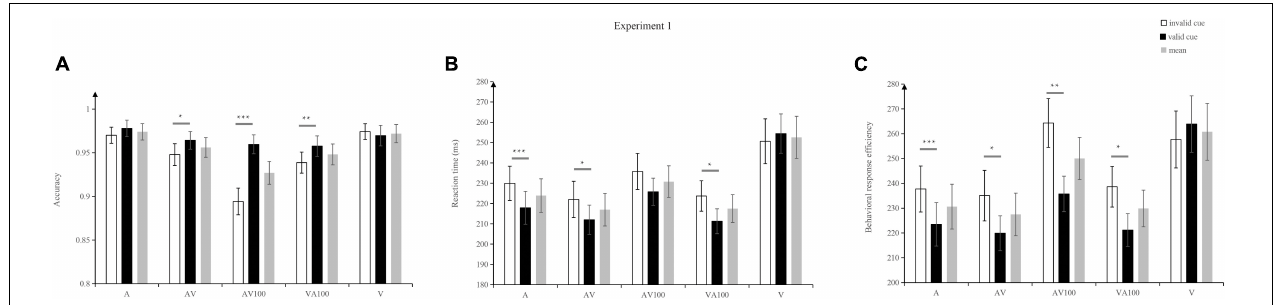
FIGURE 2 | Mean accuracy (A) , reaction times (B) , and inverse efficiency score (C) under different warning signals and cue validities in Exp. 1. V/A/AV represented visual, auditory, and audiovisual warning signal cues, respectively. The number 100 represented the interval time between two stimuli. Error bars denote ± SE. *** p < 0.001, ** p < 0.01, and * p < 0.05.